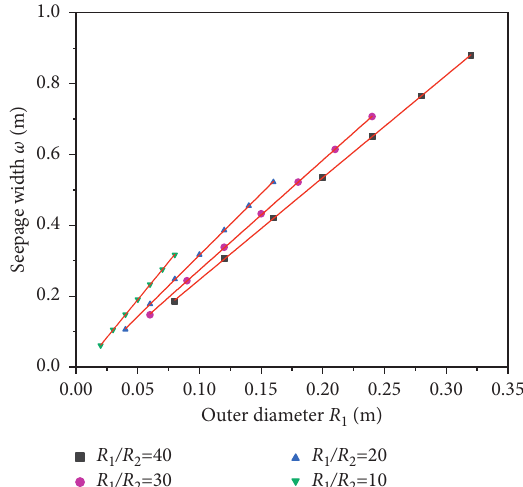
Figure 17: The variation of seepage width under fixed ratio of outer diameter to inner